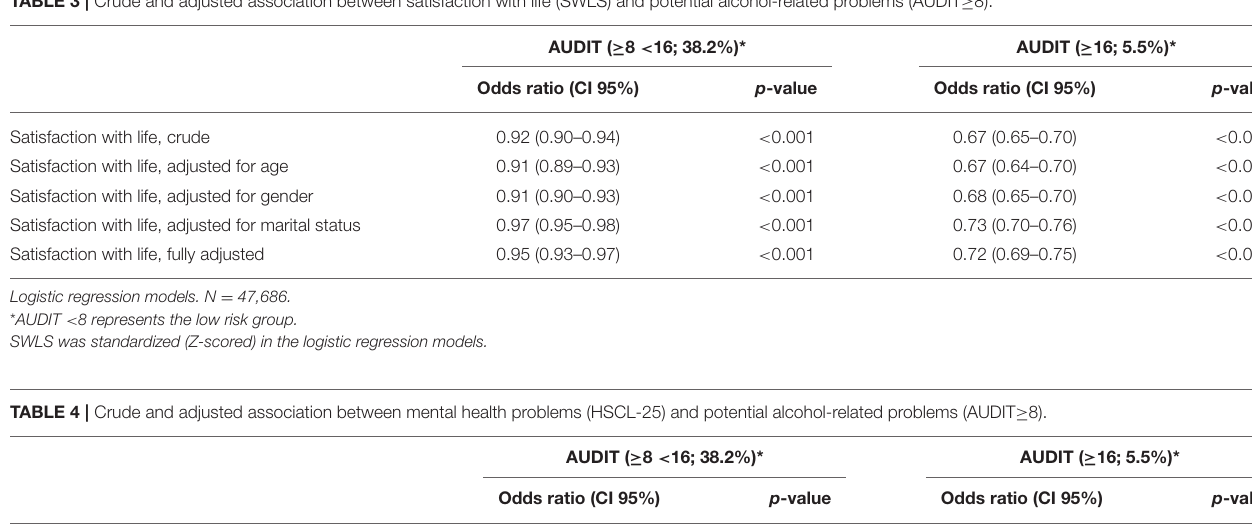
TABLE 3 | Crude and adjusted association between satisfaction with life (SWLS) and potential alcohol-related problems (AUDIT ≥ 8).